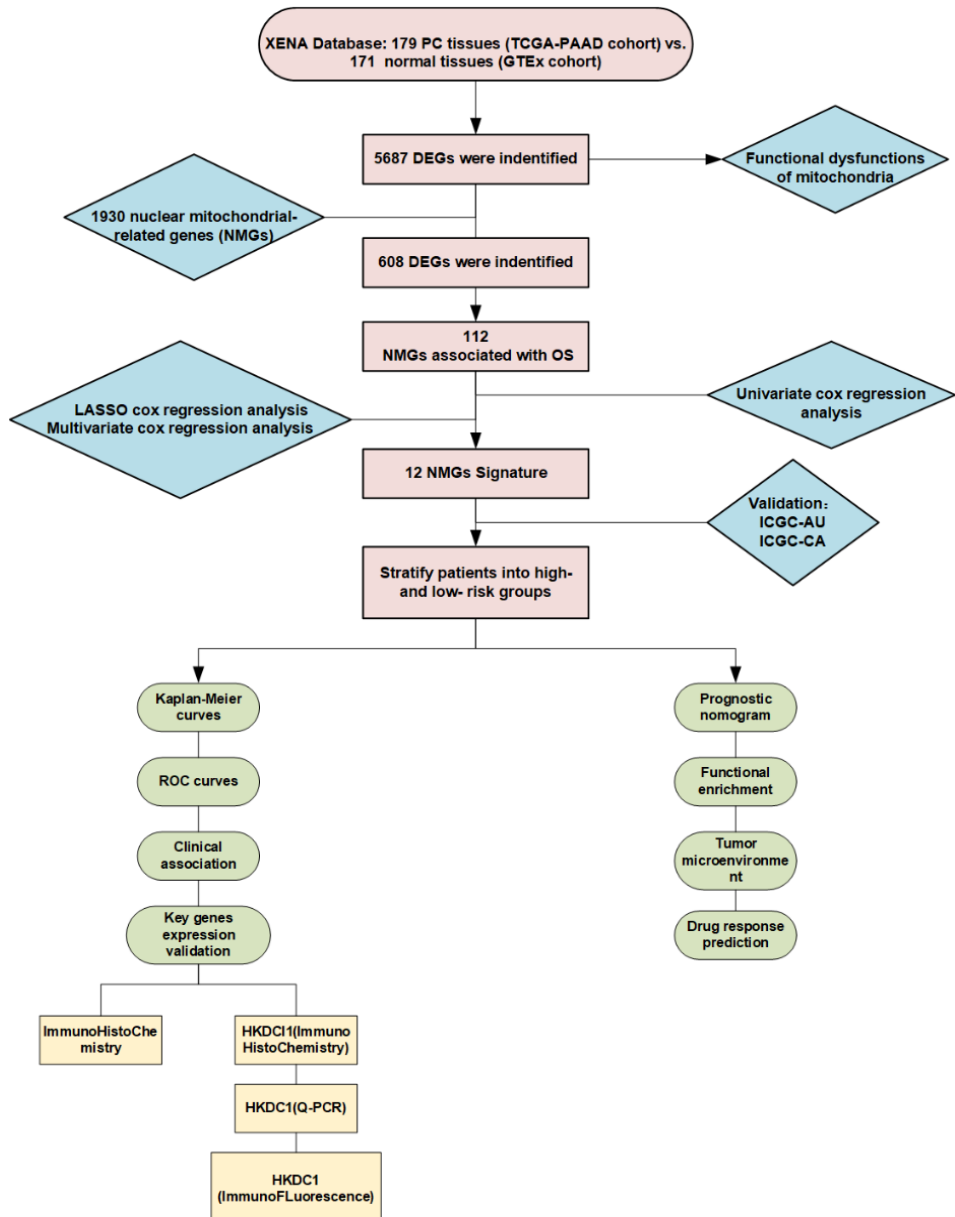
Figure 1. Flow chart of the overall research regarding nuclear mitochondria-related genes in PC.